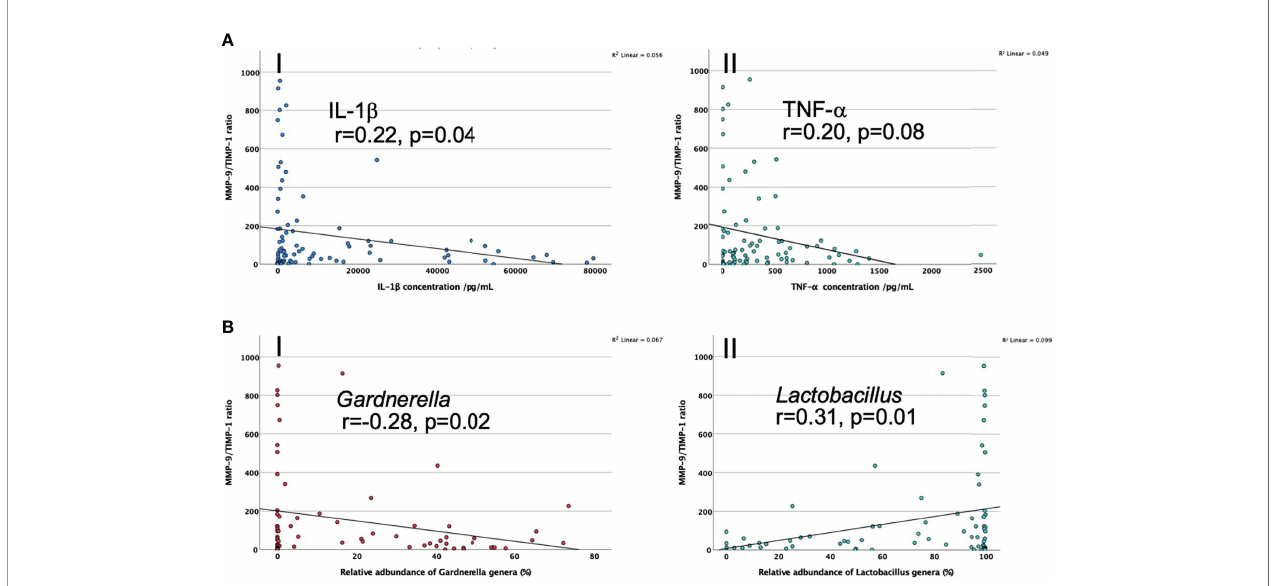
FIGURE 4 | (A) Scatter graphs to explore correlation of CVF MMP-9/TIMP-1 ratio with I. IL-1 b ; II.TNF- a in PWLWH; (B) Scatter graph to show the association between CVF MMP-9/TIMP-1 ratio and I. Gardnerella genera ; II. Lactobacillus genera in PWLWH. r = correlation co-ef fi cient, controlled for maternal age, BMI and